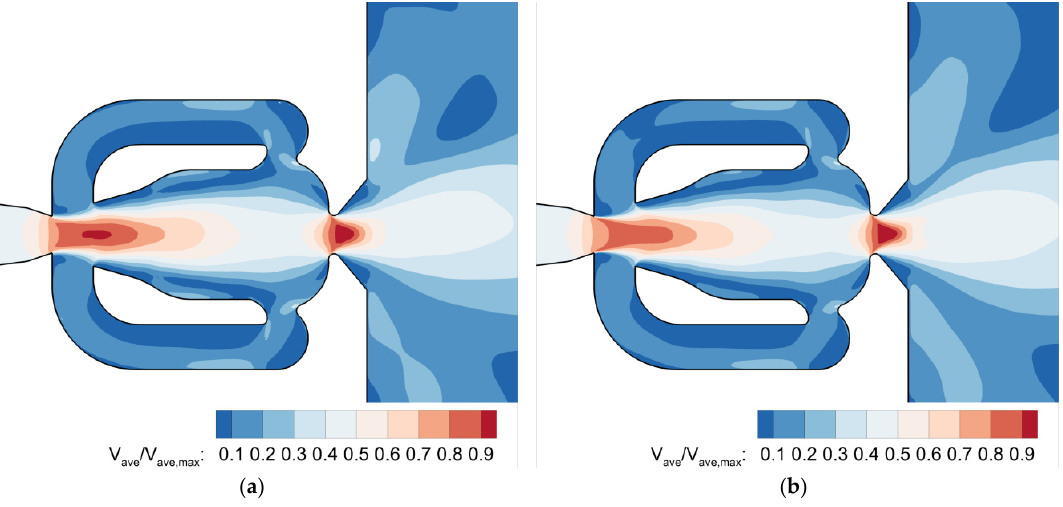
Figure 5. Time averaged velocity magnitude contour on z = 0 plane for ( a ) N10 V ave,max = 169.4 and ( b ) N80 V ave,max = 172.7 m/s. Reproduced with permission from [9].